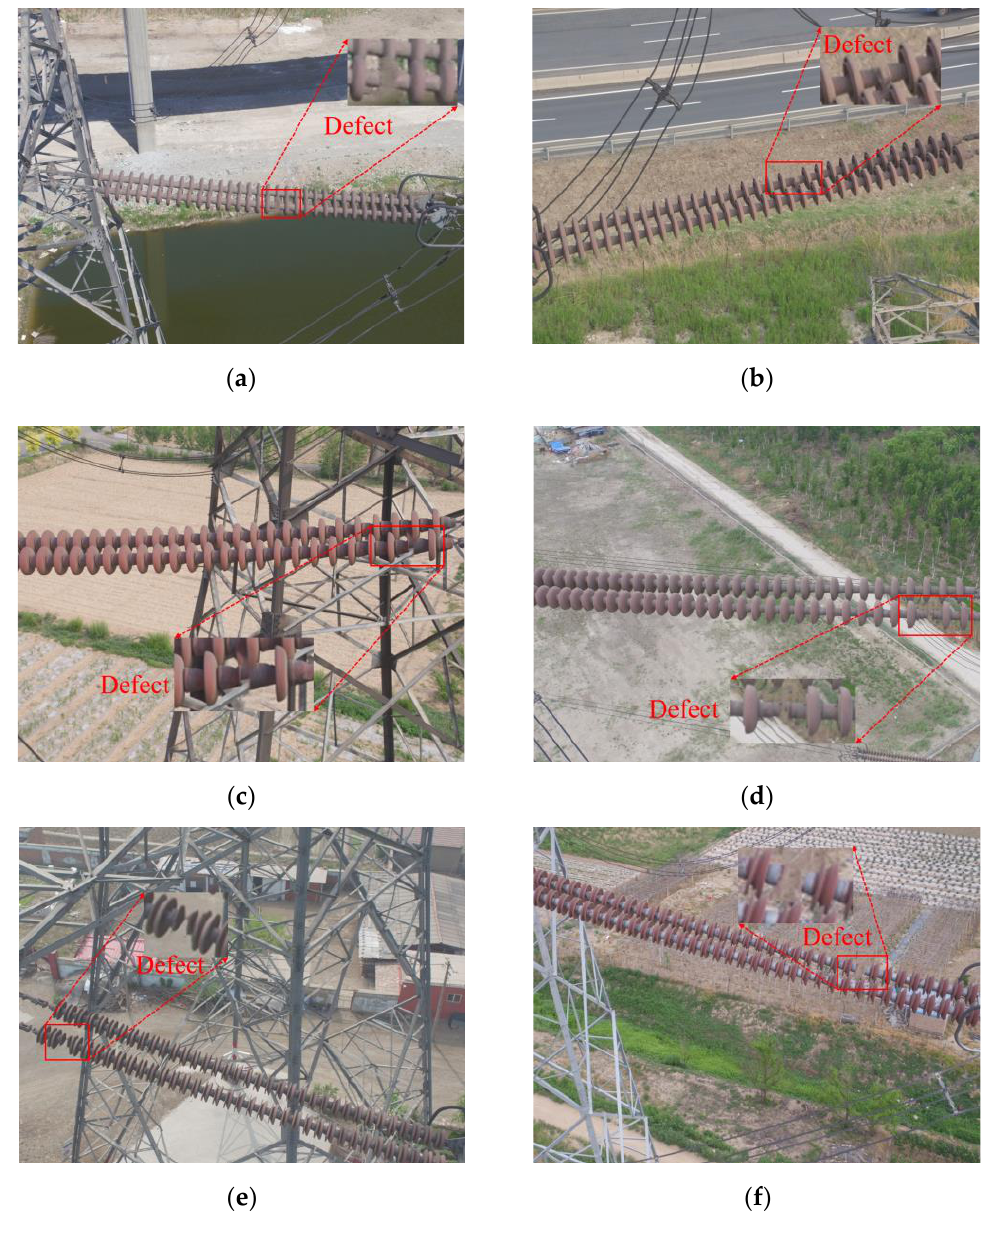
Figure 6. ( a – f ) Insulator defect pictures.